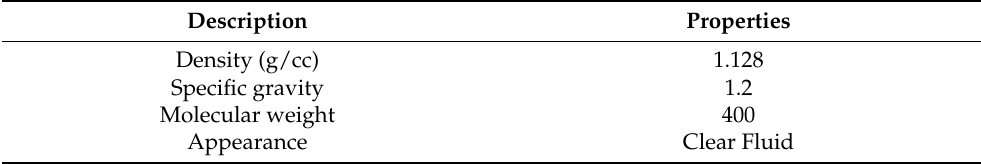
Table 4. Properties of PEG-400 (Source: alpha-chemika, 2019).